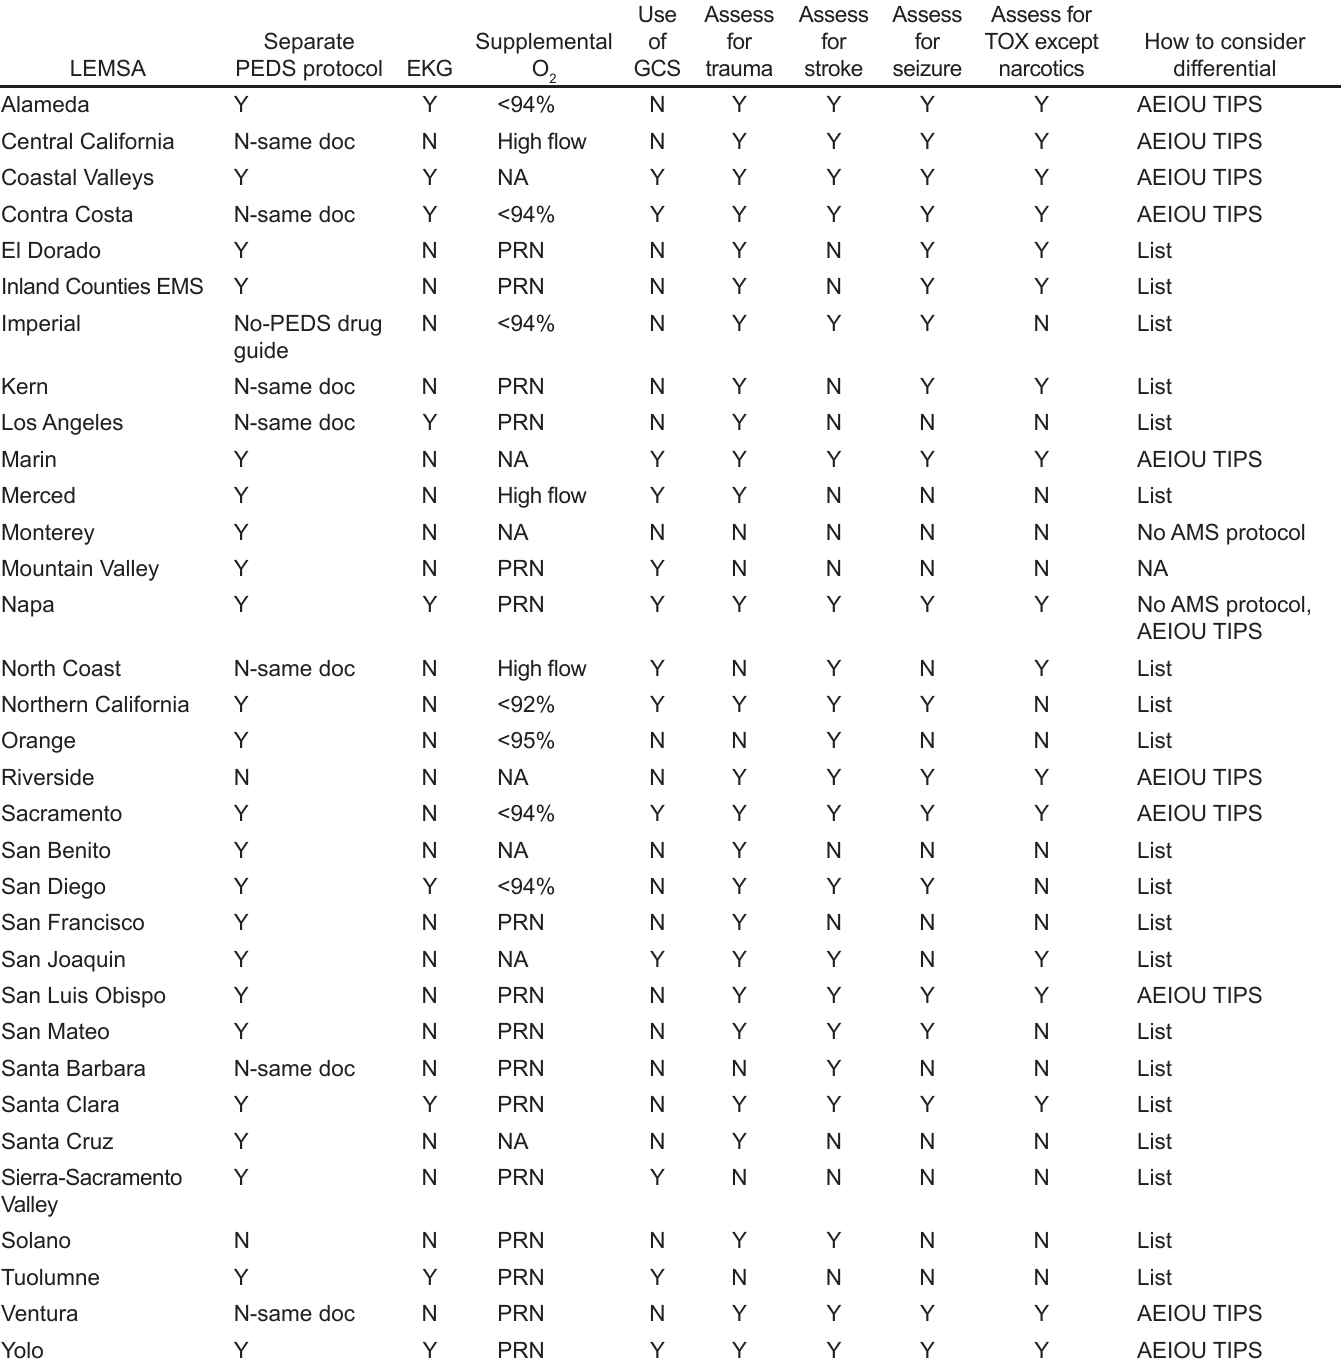
Table 3. Evaluating patients for various etiologies of altered mental status